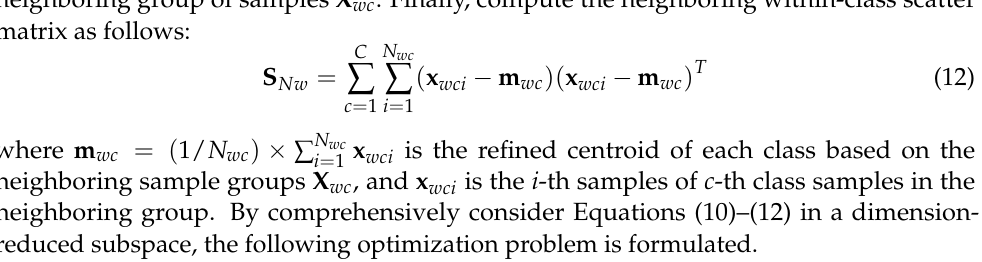
At the same time, the N b global neighboring samples are used to calculate the covari- ance matrix as